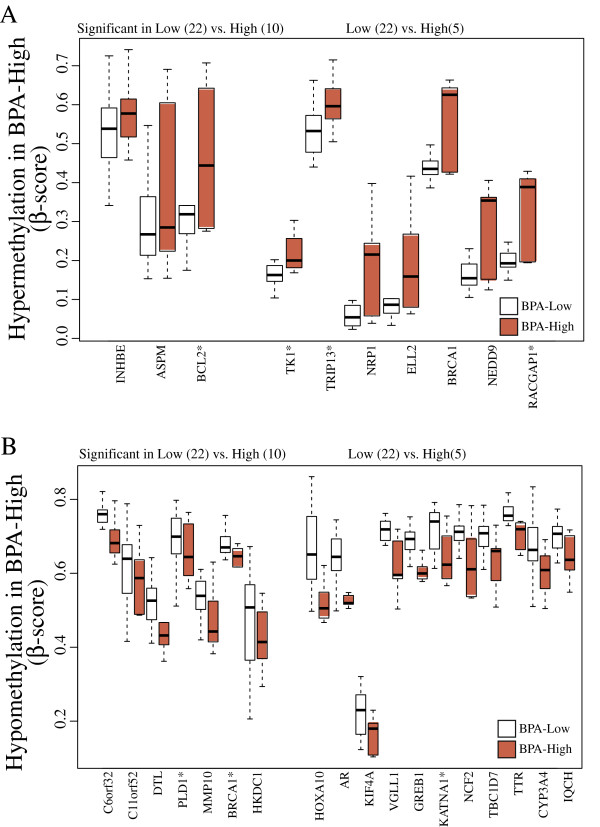
Differential methylation observed in genes known to be interacting with BPA from the Comparative Toxicogenomics Database (CTD). (A) Top candidate genes that undergo hypermethylation in BPA-high vs. BPA-low groups. (B) Top candidate genes that undergo hypomethylation in BPA-high vs. BPA-low groups. The reported expression change in genes with the asterisk did not inversely correlate with the methylation status.